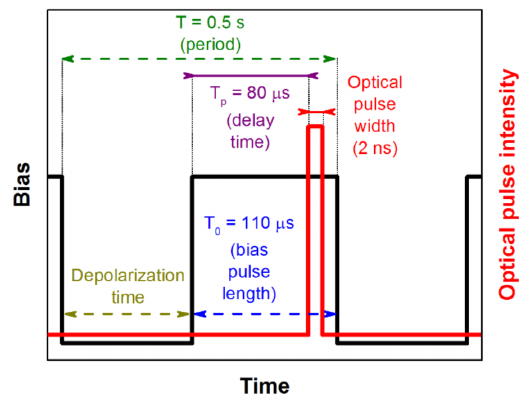
Figure 5. Diagram of the pulsed bias cycle.